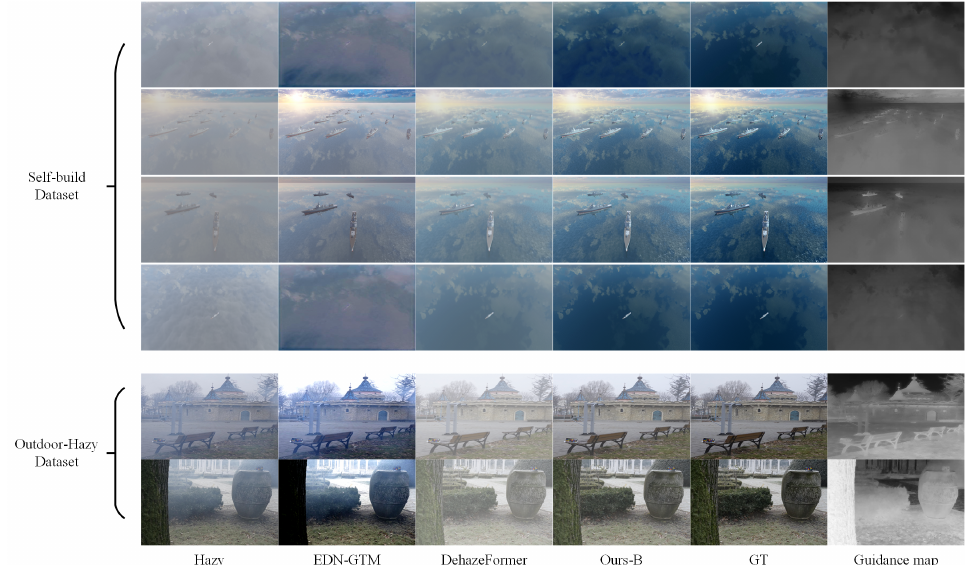
Figure 8. The results obtained with the state-of-the-art algorithms on the self-built dataset and O-Haze dataset. The top four rows show the dehazing results on the self-built dataset, and the bottom two rows show the dehazing result on the O-Haze public dataset. Table 2. Quantitative defogging results of the self-built data set and O-Haze data set.